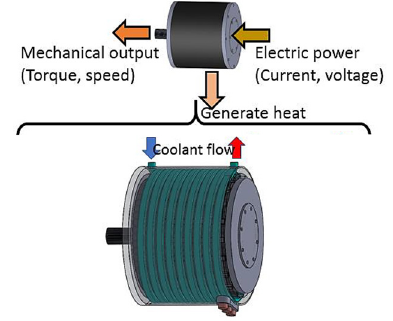
Figure 5. Approach to the